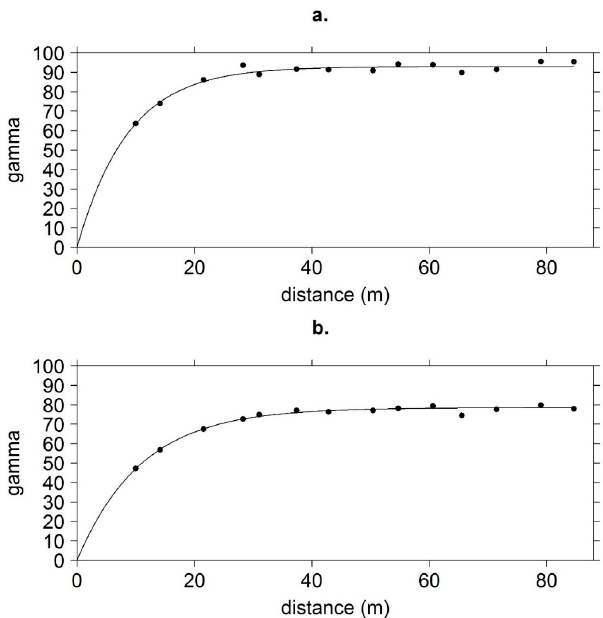
Figure 1. Live ponderosa pine basal area variograms ( a ) pre- and ( b ) post- a MPB event. Gamma is the squared variability of the basal area across distance (m 2 /ha) 2 . Arapaho-Roosevelt National Forest, Colorado, USA. Insects 2020 , 11 , x FOR PEER REVIEW